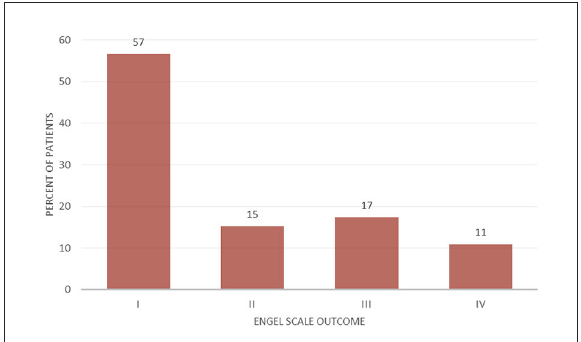
FIGURE2 Engel scale seizure outcome after insular LITT for epilepsy ( n = 46).